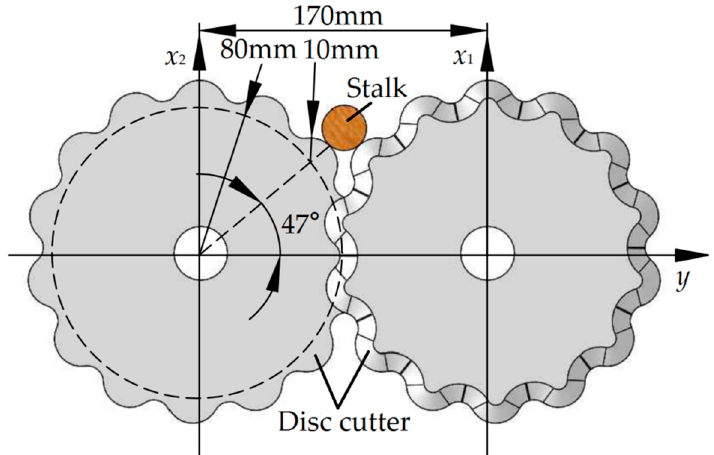
Figure 2. Double-disc cutting system consisting of wave-type disc cutters.